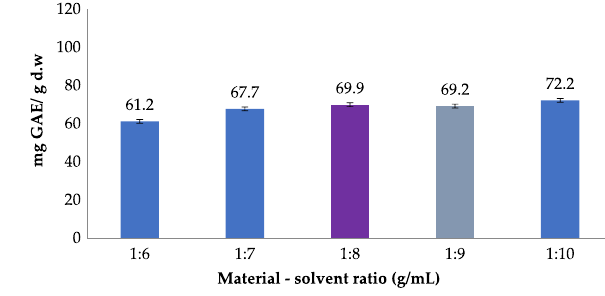
Figure 3: Polyphenol extraction a ff ected by material – solvent ratio ( Operating conditions: ethanol concentration of 70% ( v/v ) ; tem - perature of 60°C; operating time of 30 min; and 2 extraction cycles )